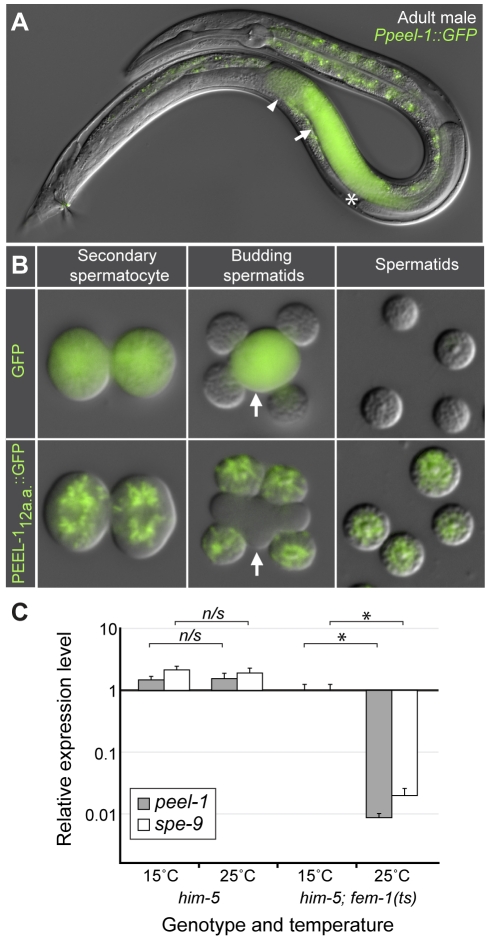

peel-1 is expressed exclusively in sperm and carries an N-terminal sperm localization signal.(A) Adult male expressing Ppeel-1::GFP. The tube-like gonad begins at the asterisk, extends toward the head, folds over on itself, and then extends toward the tail. The arrow and arrowhead indicate spermatocytes and sperm, respectively. Fluorescence outside the gonad is auto-fluorescence. Nomarski and fluorescence channels are overlaid. (B) Secondary spermatocytes, budding spermatids, and mature spermatids expressing either untagged GFP or GFP tagged with the N-terminal 12 amino acids of PEEL-1 (PEEL-112a.a.::GFP). Arrows indicate residual bodies. Nomarski and fluorescence channels are overlaid. (C) Relative expression levels of peel-1 and spe-9 in him-5(e1490) and him-5(e1490) fem-1(hc17ts) adult males at the permissive (15°C) and restrictive (25°C) temperatures. him-5(e1490) was included to aid in collection of males. Expression levels were calculated relative to the him-5(e1490) fem-1(hc17ts) 15°C sample. Runs were performed in triplicate and standard deviations are shown. * p<10−5, one-tailed Student's t test on the normalized expression levels. n/s, p>0.05.